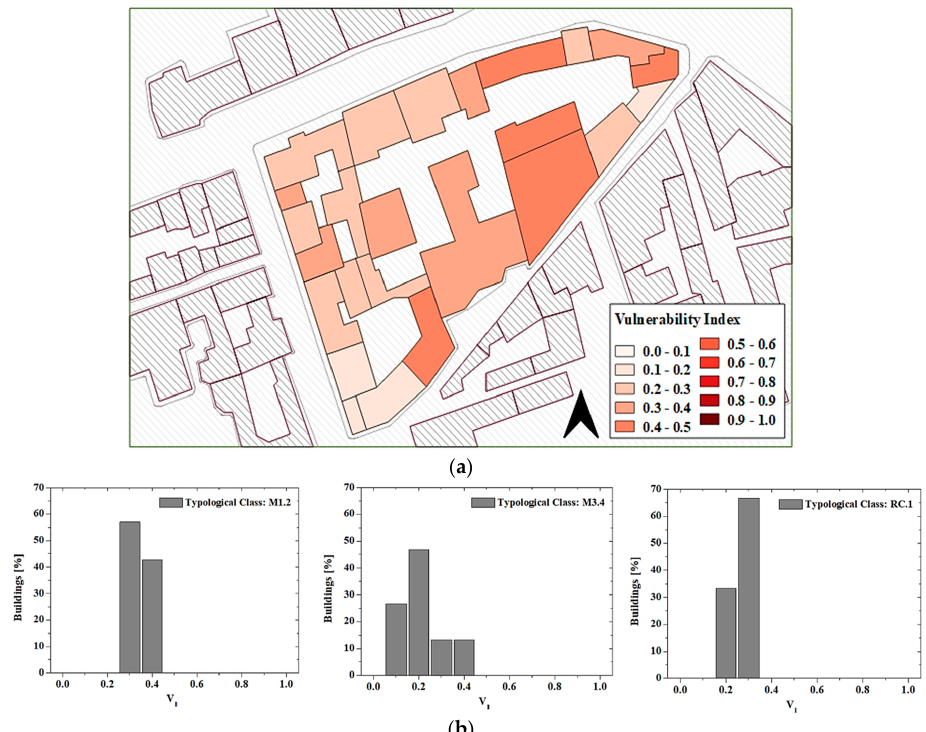
Figure 5. Vulnerability analysis results: ( a ) index distribution; ( b ) vulnerability frequencies for each typological classes.